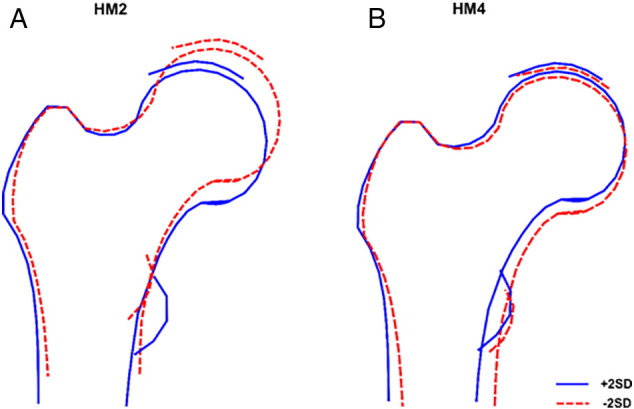
Line drawings of hip modes (HM) 2 and 4 showing ± 2 standard deviations (SD) from mean hip shape.